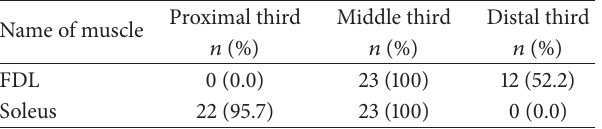
Table 2: Number of specimens that have muscle fibres attachment in the different segments of posteromedial border of the tibia.